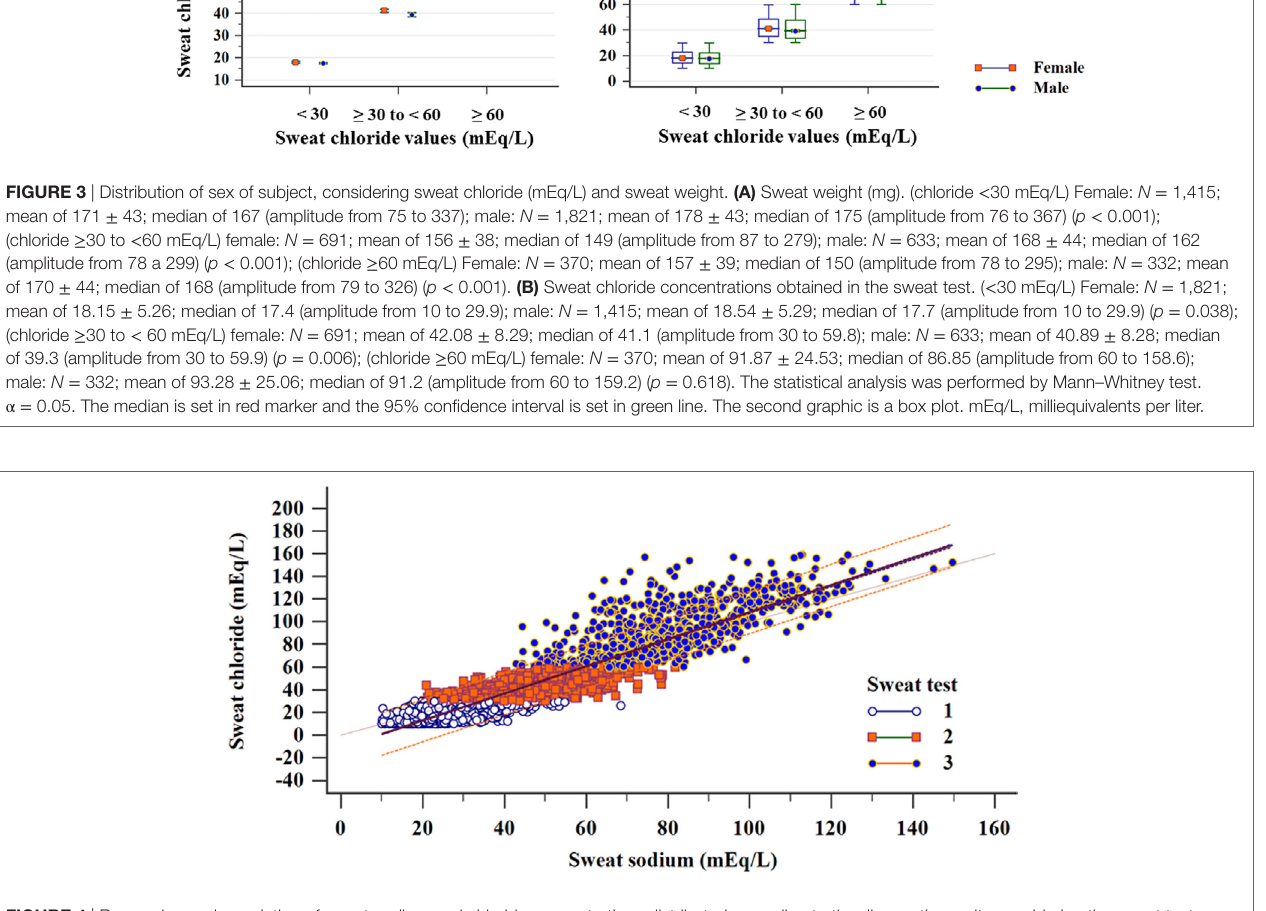
FigUre 4 | Regression and correlation of sweat sodium and chloride concentrations distributed according to the diagnostic results considering the sweat test values (total sample). Linear regression: N = 5,277; R 2 = 0.877; y = − 11.05 + 1.1932 x ( p < 0.001). Correlation: N = 5,277; correlation coefficient r = 0.9365; 95% CI = 0.9331–0.9397 ( p < 0.001); (1) N = 3,249; R 2 = 0.4347; y = 5.8091 + 0.4955 x ( p < 0.001); (2) N = 1,324; R 2 = 0.4913; y = 14.5228 + 0.5888 x ( p < 0.001); (3) N = 702; R 2 = 0.5336; y = 11.4797 + 1.0064 x ( p < 0.001). (i) chloride < 30 mEq/L; (ii) chloride ≥ 30 to < 60 mEq/L; and (iii) chloride ≥ 60 mEq/L. α = 0.05. mEq/L, milliequivalents per liter; 95% CI, confidence interval of